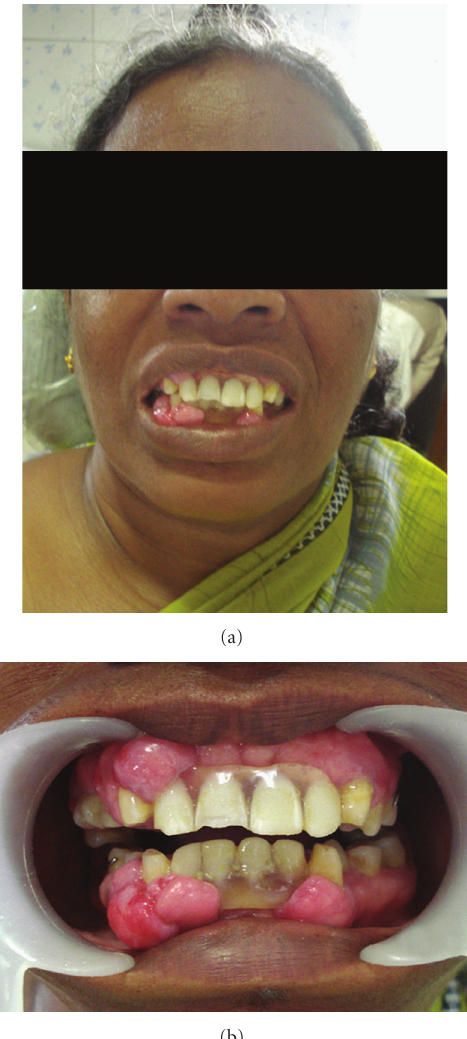
Figure 5: Showing mothers photograph and intraoral front